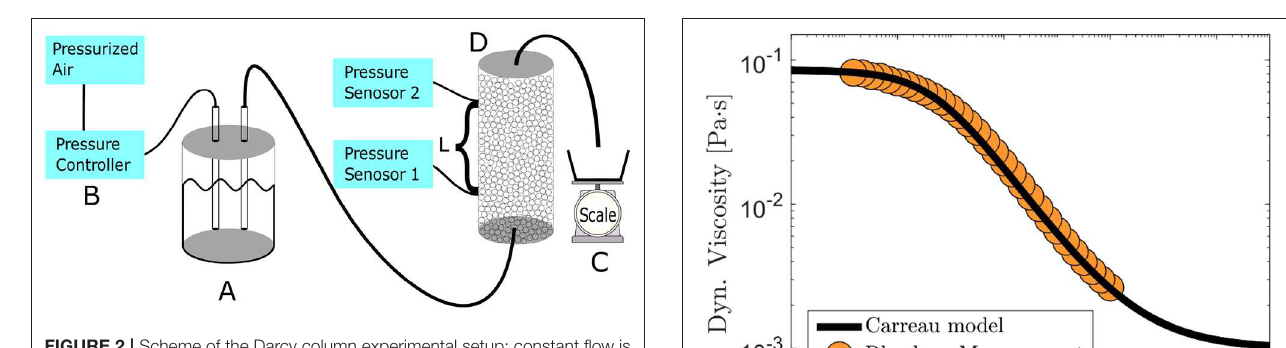
FIGURE 2 | Scheme of the Darcy column experimental setup: constant flow is imposed from the Boyle-Mariotte bottle (A) by compressed air from pressure controller (B) . We measured the outflow on a scale (C) and the pressure drop at the column with two sensors (D) , where the distance between the sensors defines L.